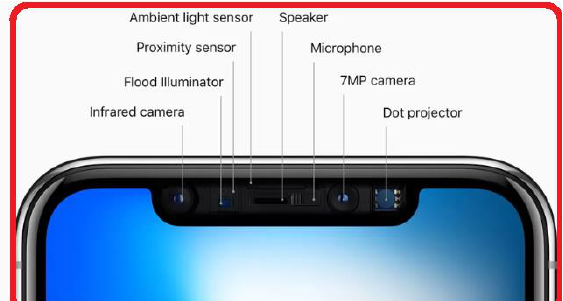
Figure 32. The iPhone X’s notch is basically a Kinect.